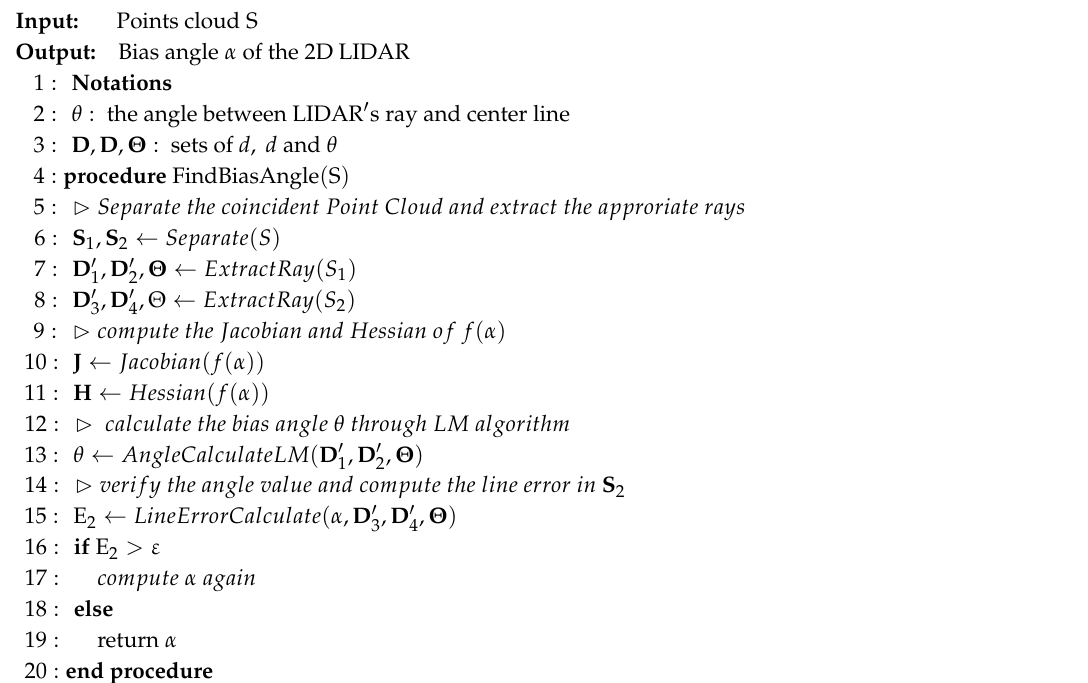
Algorithm 1: Bias angle calibration based on Levenberg–Marquardt